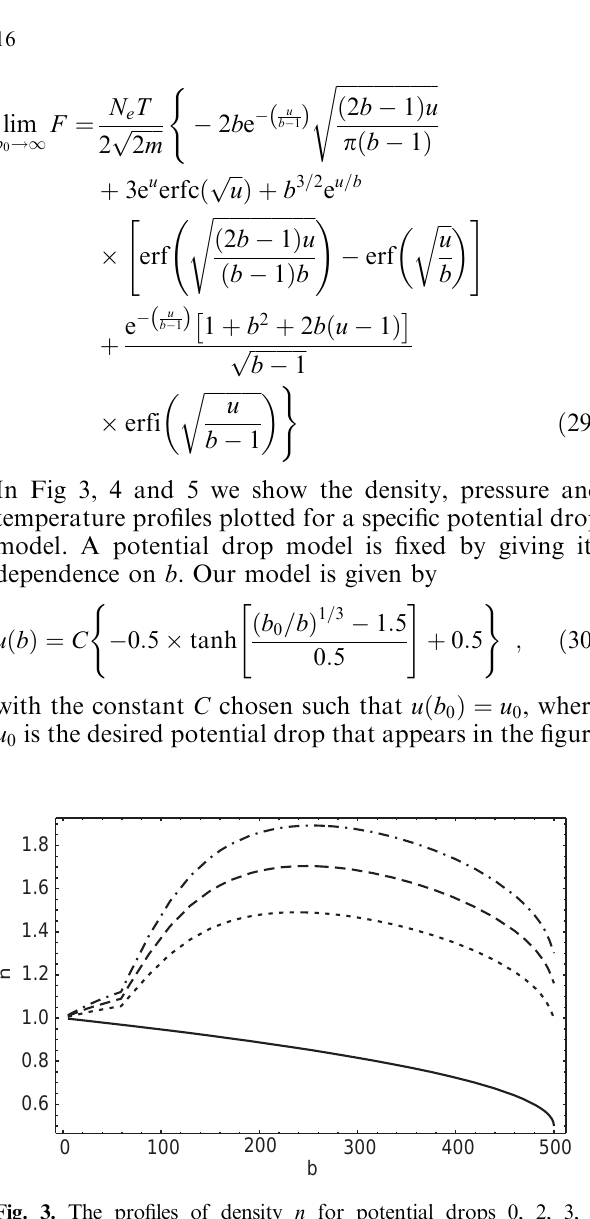
Fig. 3. The profiles of density n for potential drops 0, 2, 3, 4 corresponding to solid , dotted , dashed , and dot-dashed curves , respectively. The dimensionless potential drops u are normalized to the source plasma thermal energy. The curves were obtained by using